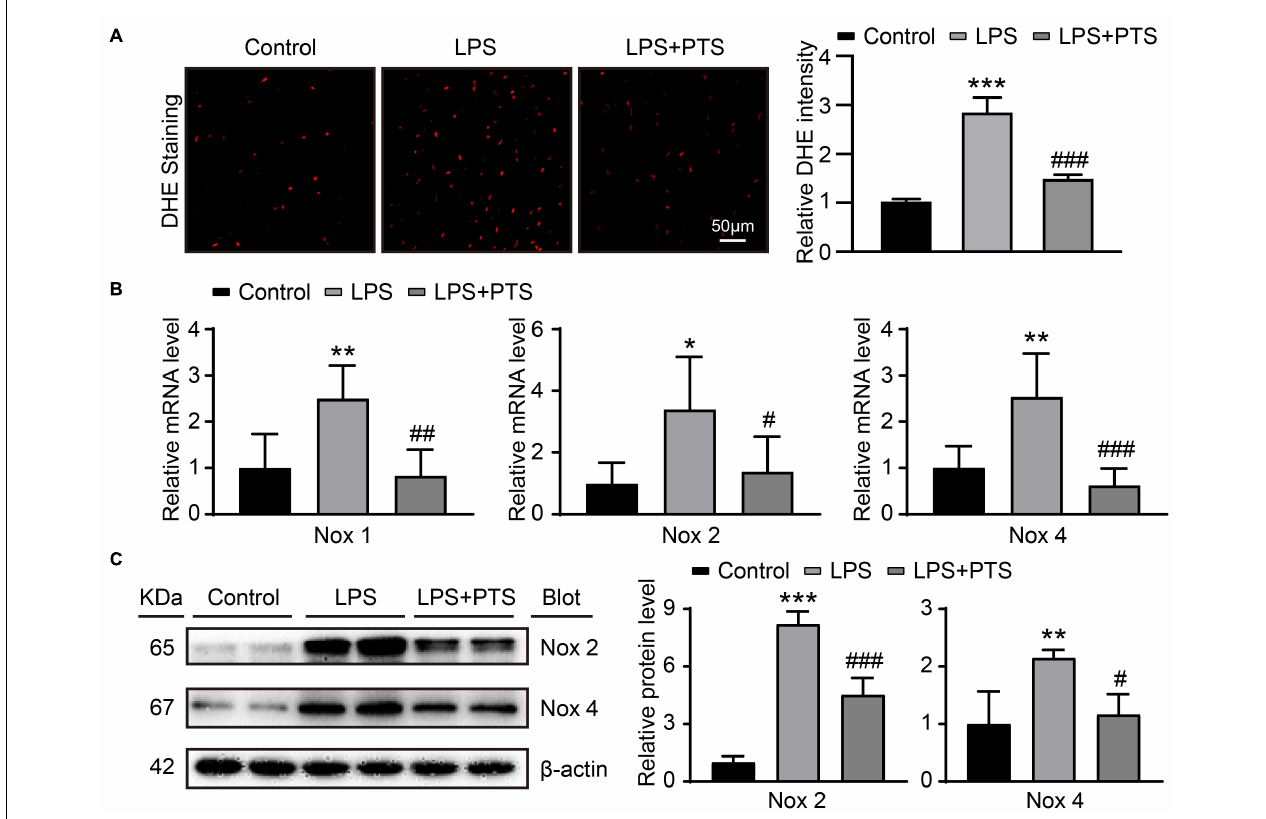
FIGURE 4 | PTS reduces oxidative stress in the hearts of mice with LPS-Induced septic mice. (A) Representative of DHE from control group, LPS group, and LPS + PTS group on the left and quantitative data are shown on the right ( n = 6). (B) The mRNA levels of NOX1, NOX2, and NOX4 in heart tissue from control group, LPS group, and LPS + PTS group were detected by qPCR ( n = 6). (C) Expressions of NOX2 and NOX4 protein in heart tissue were measured by Western blotting analysis ( n = 4). * P < 0.05, ** P < 0.01, *** P < 0.001 control vs. LPS, # P < 0.05, ## P < 0.01, ### P < 0.001 LPS vs. LPS +